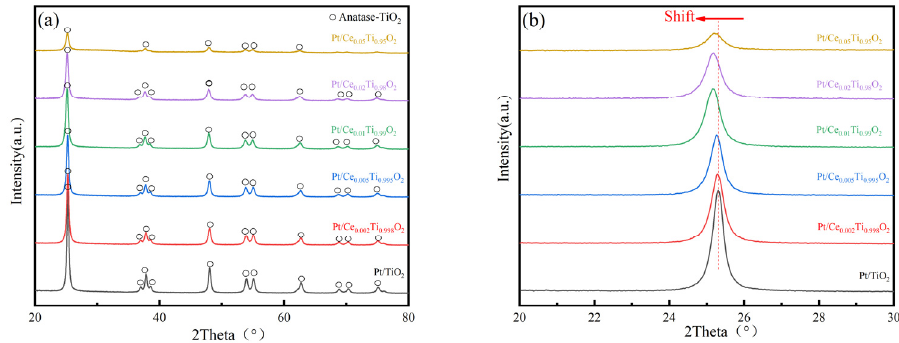
Figure 3. ( a ) XRD patterns and ( b ) partially enlarged detail of XRD patterns of Pt/Ce x Ti 1 − x O 2